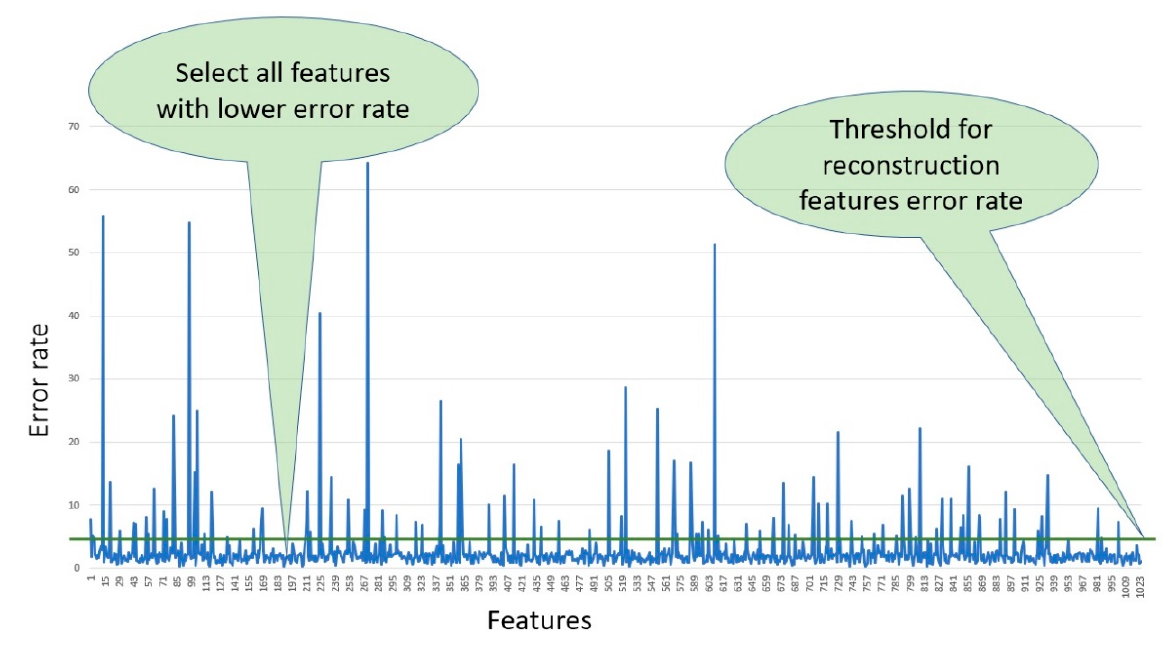
Figure 8. Reconstruction features’ error rates.